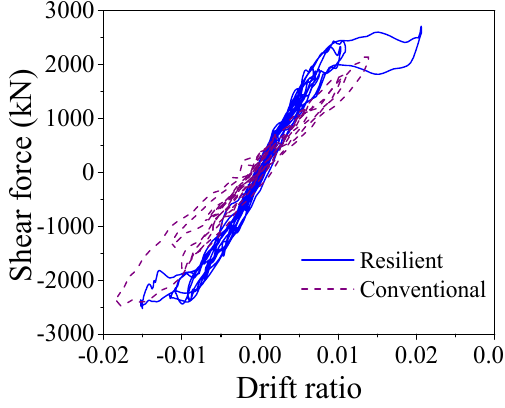
Figure 19. Shear force vs. drift ratio.